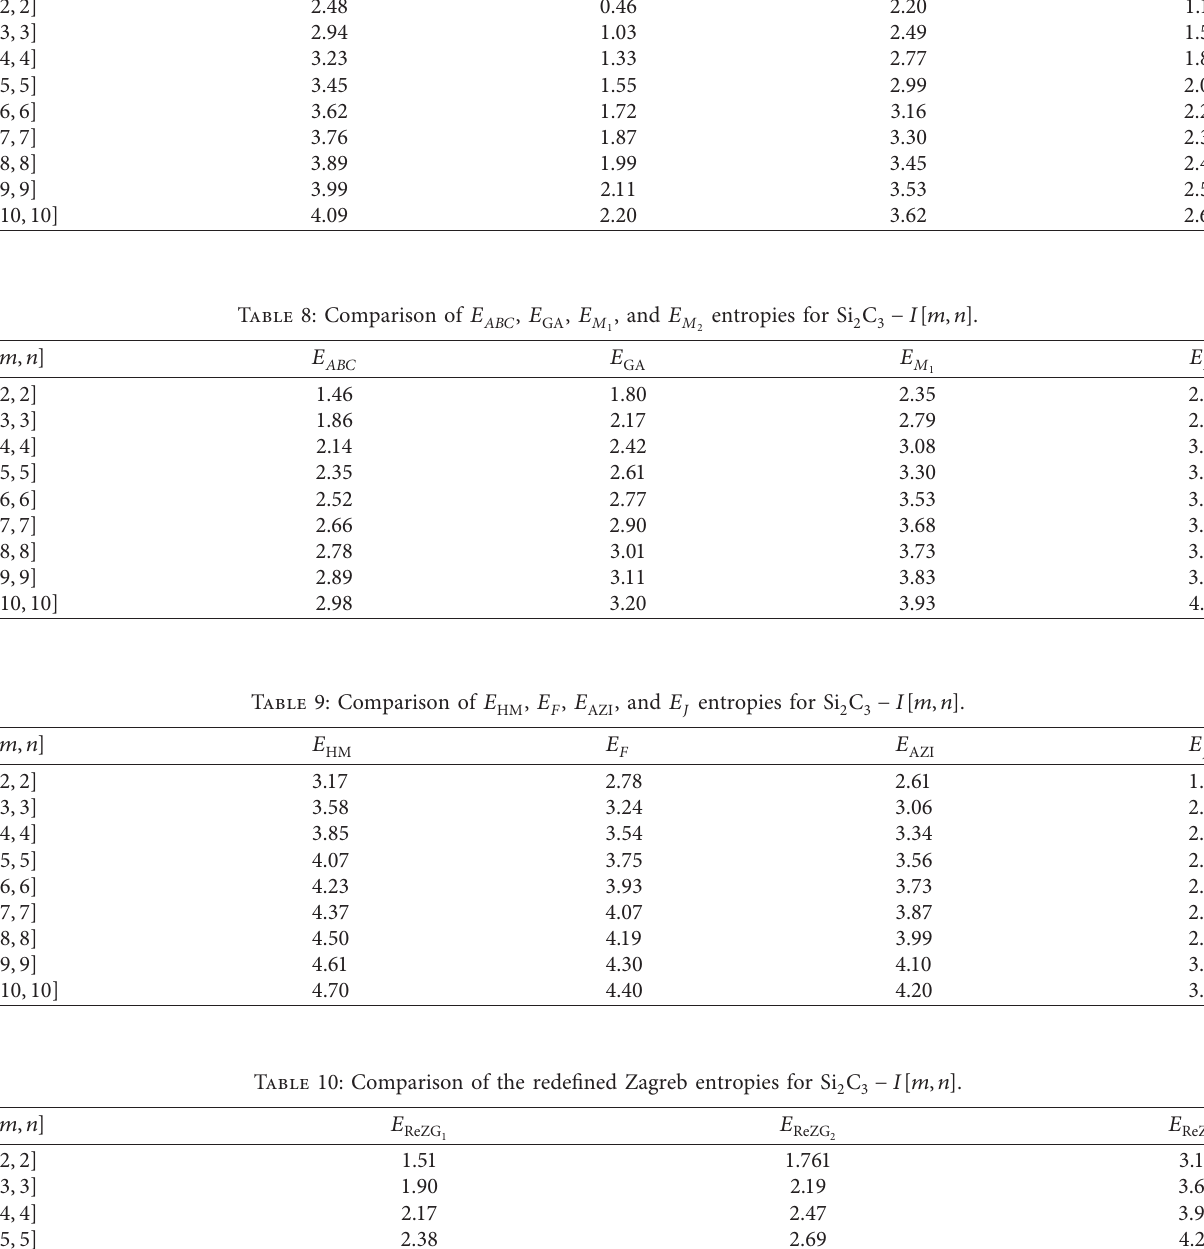
Table 7: Comparison of Randi´c entropies for Si